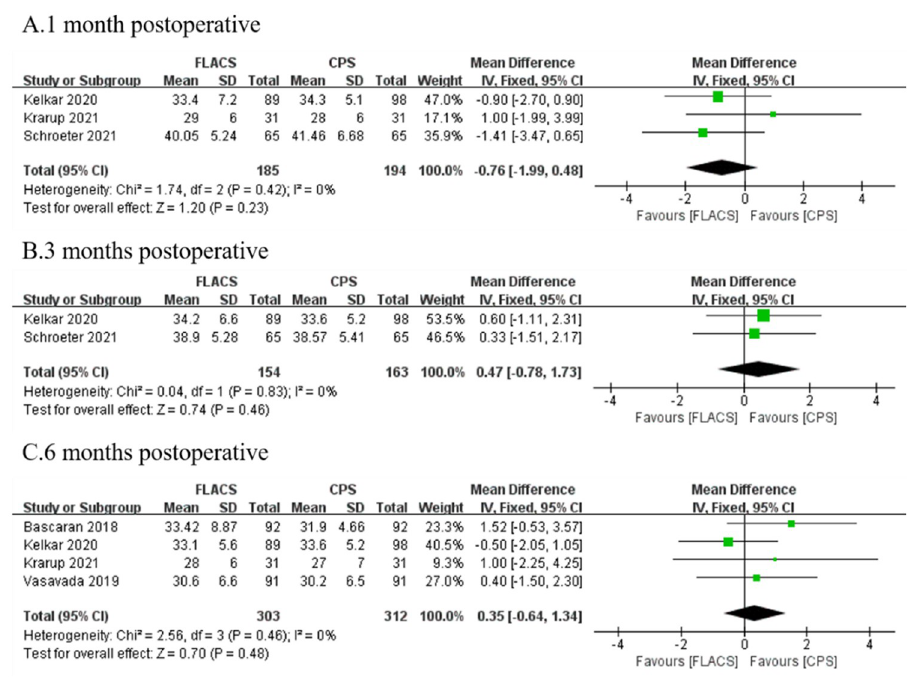
Fig 7. Forest plot of postoperative 6A between FLACS and CPS at A. 1 month, B. 3 months, and C. 6 months.